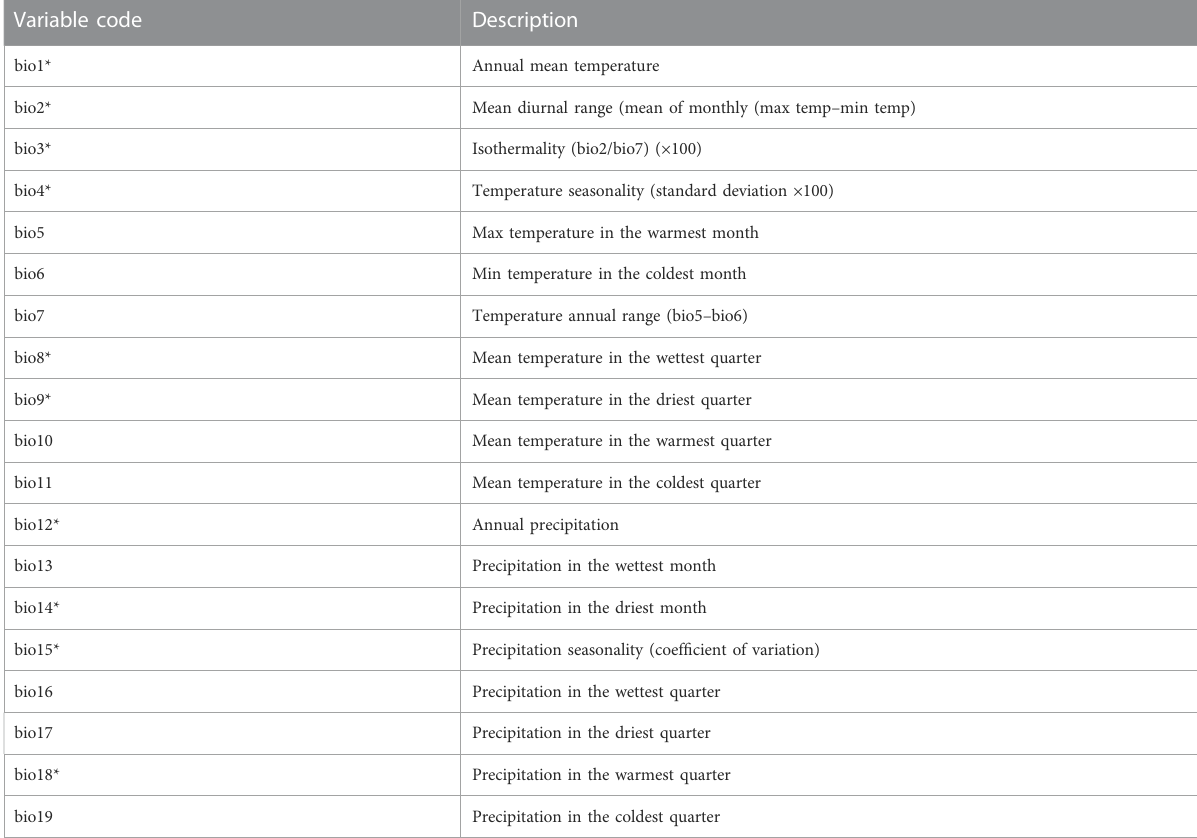
TABLE 1 List of variables used in the PCA and modeling (with an asterisk). Variable